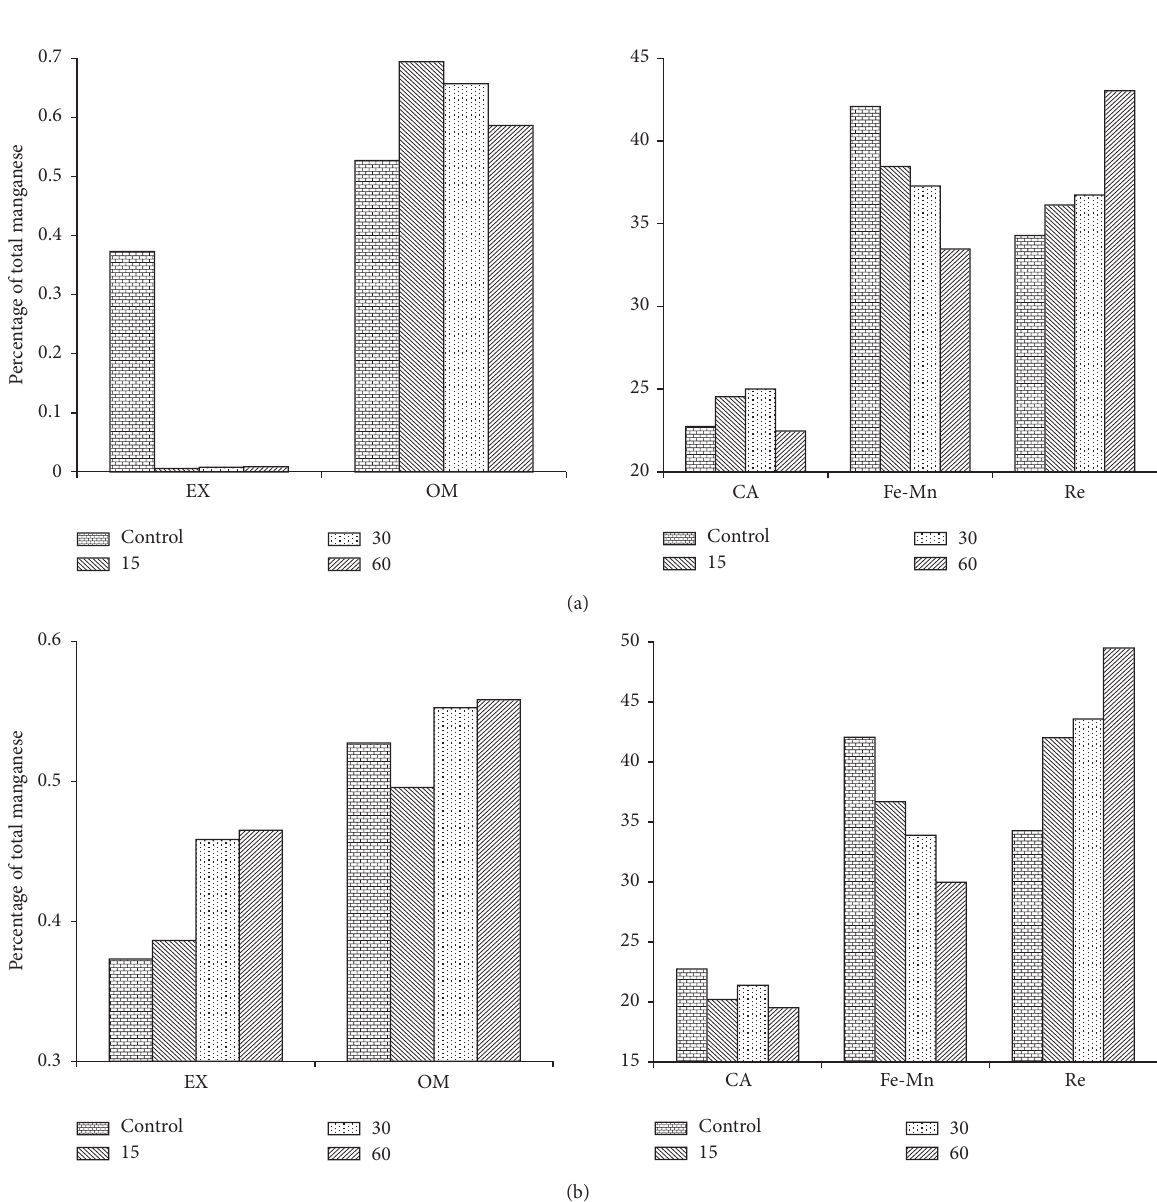
showed that almost in all studied samples, carbonate-bonded fraction after residual and Fe and Mn oxides has the highest Mn amounts. Mn amount in this fraction after addition of compost levels, separately in each year, significantly increased ( 𝑃 < 0.01 ), while Mn amount in all treatments from one-time application to two-time significantly decreased ( 𝑃 < 0.05